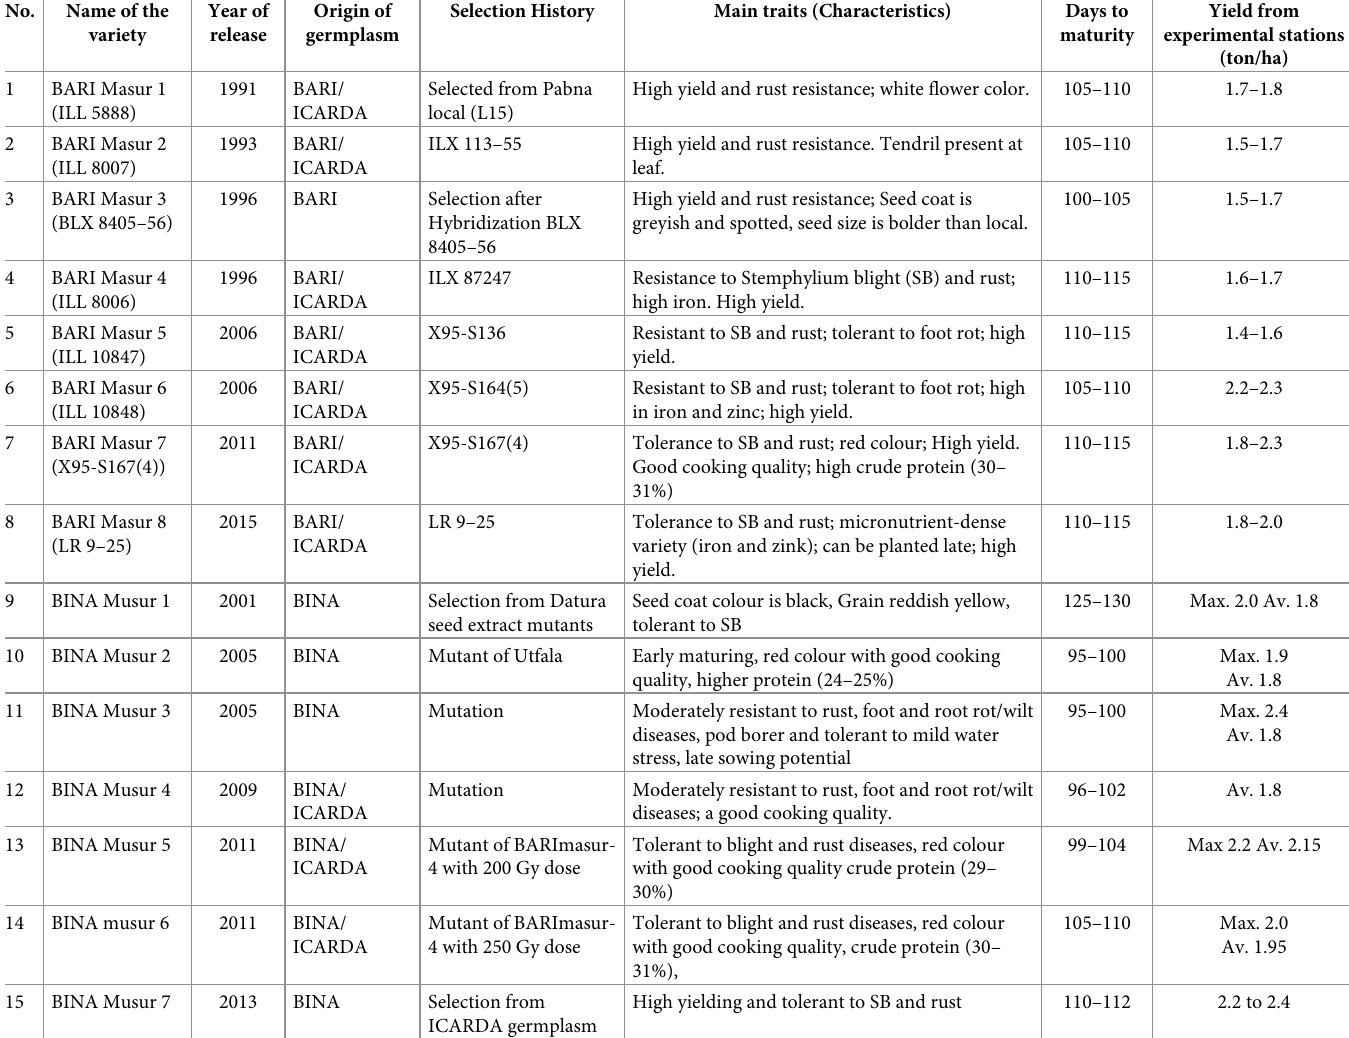
Table 1. Lentil varieties released in Bangladesh between 1991 and